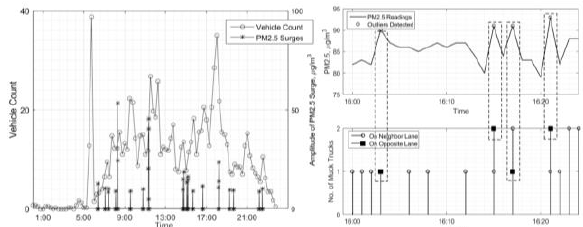
Figure 8 . Left: Vehicle count records at a crossroad and identified PM 2.5 surges of a station nearby; Right: Muck truck records and PM 2.5 records of Station 26. (Fan et al., 2021) On October 29th, 2020, we mounted Station 26 upon a suitcase 0.5 meters above the pavement, with its inlet toward the